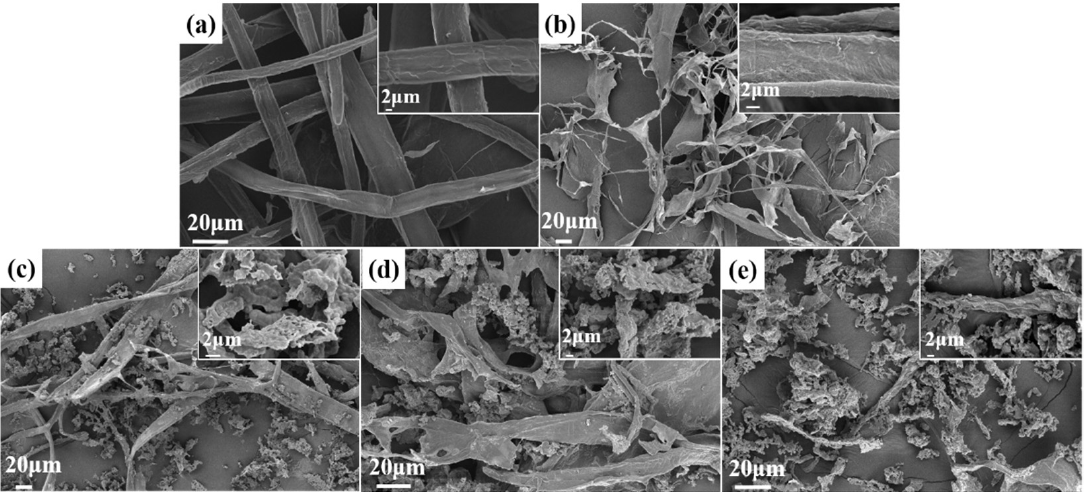
Figure 2. SEM micrographs of ( a ) the raw material C-0, ( b ) 10 times ground C-10, ( c ) 20 times ground C-20, ( d ) 25 times ground C-25, and ( e ) 30 times ground C-30. C-0 represents raw pulp fibers and C-10, C-20, C-25, and C-30 represent fibers that have been grounded 10, 20, 25, and 30 times by a high-consistency refiner, respectively.